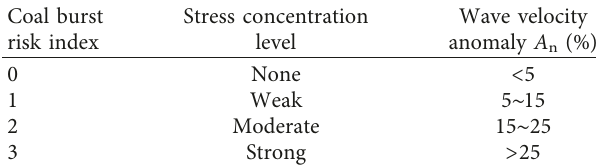
Figure 10: Layout and profile of the LW5521-20 panel. (a) Layout of the LW5521-20 panel. (b) A-A profile. Table 3: Relation between the wave velocity anomaly and the stress concentration